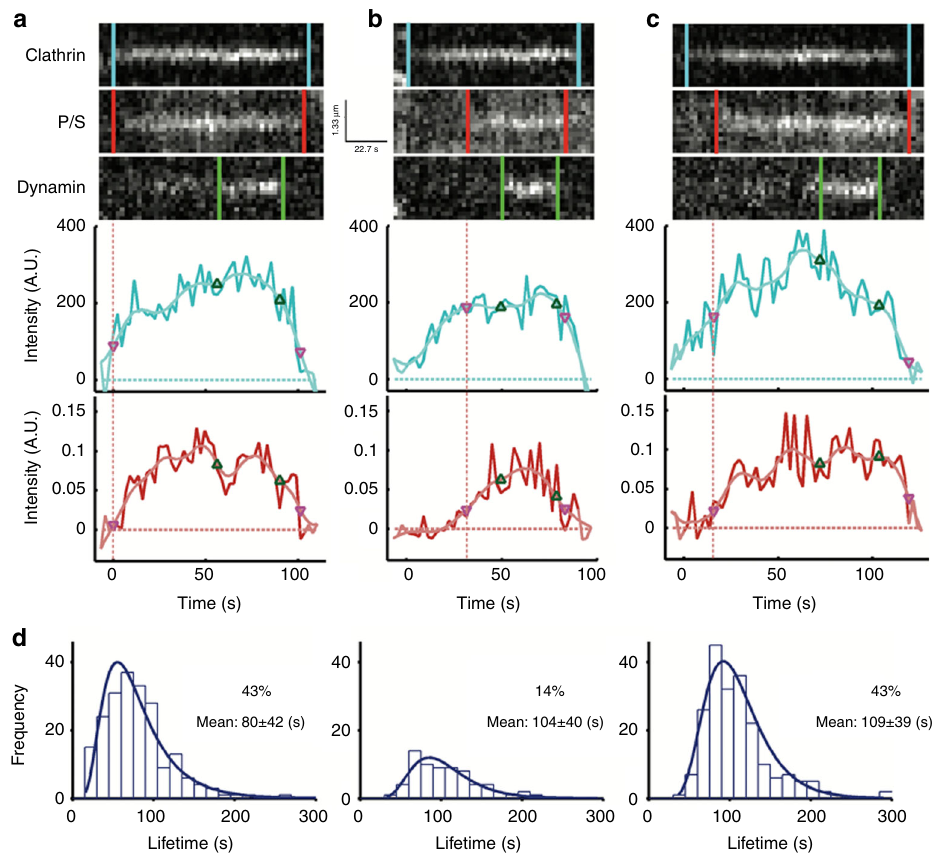
Fig. 3 Distinct modes of membrane bending observed by pol-TIRF. a – c Kymographs of clathrin-Tq2, membrane bending (P/S), dynamin-eGFP, and corresponding intensity traces for clathrin (cyan) and P/S (red) for the three classes of membrane bending observed by pol-TIRF. The colored lines indicate the lifetime for each event, the dashed red line highlights the start of P/S event. a Class 1: clathrin and P/S signals proceed together indicating membrane bending as clathrin assembles. b Class 2: clathrin signal plateaus prior to the start of P/S indicating all required clathrin was present as a fl at sheet. c Class 3: clathrin assembles prior to P/S signal, but new clathrin was recruited as the membrane bends and the vesicle is formed. d The clathrin lifetime histogram of each class from an average of four cells ( N = 481 tracks